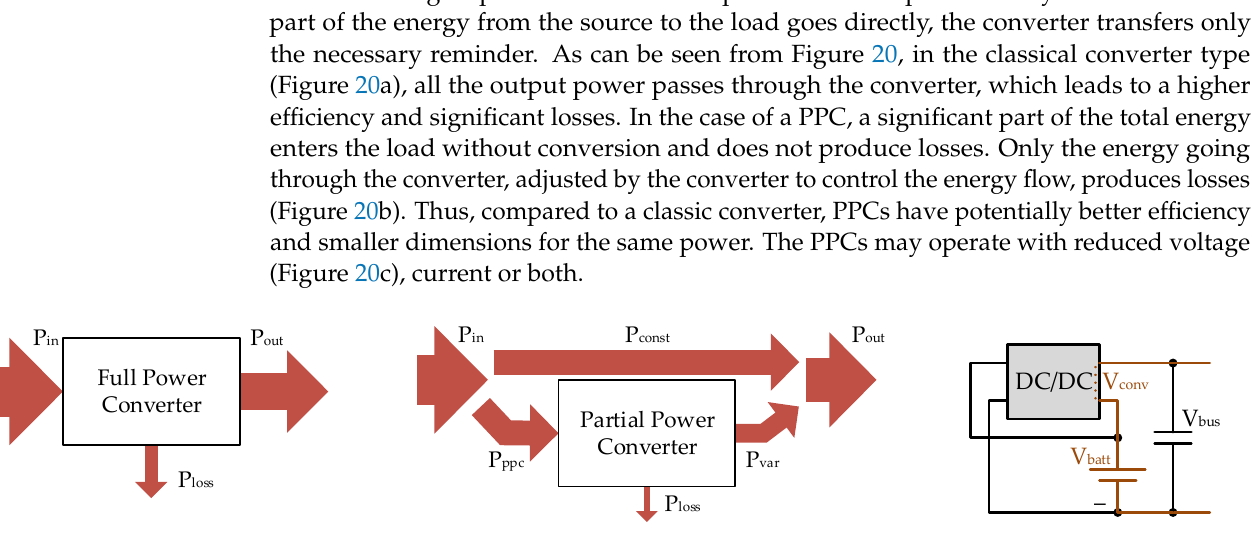
Figure 20. Full power operation vs. partial power operation: ( a ) power distribution in full power converter, ( b ) power distribution in partial power converter, ( c ) diagram showing operation with reduced voltage.